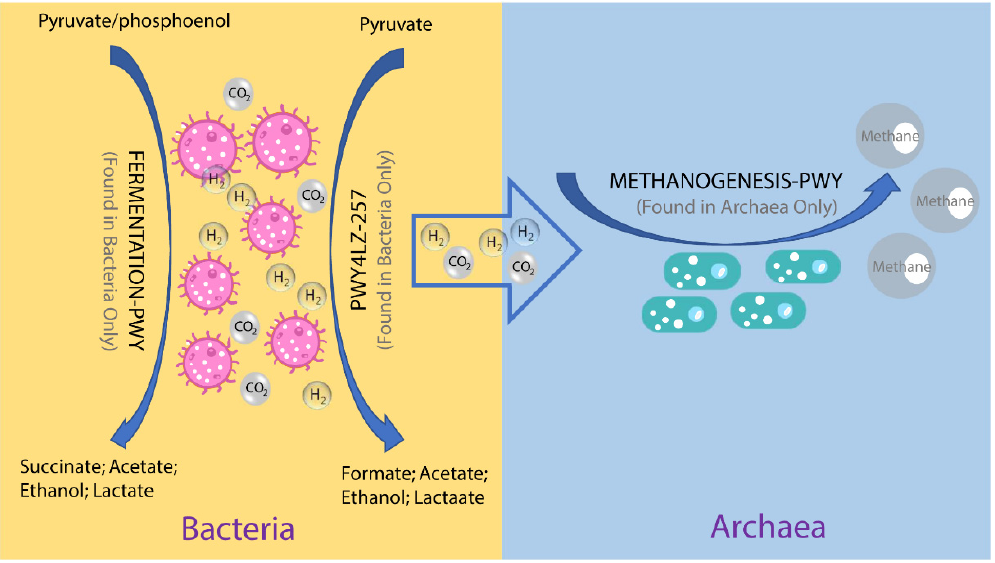
Figure 5. Overview of the hydrogen production pathways of bacteria and consumption pathway of archaea.